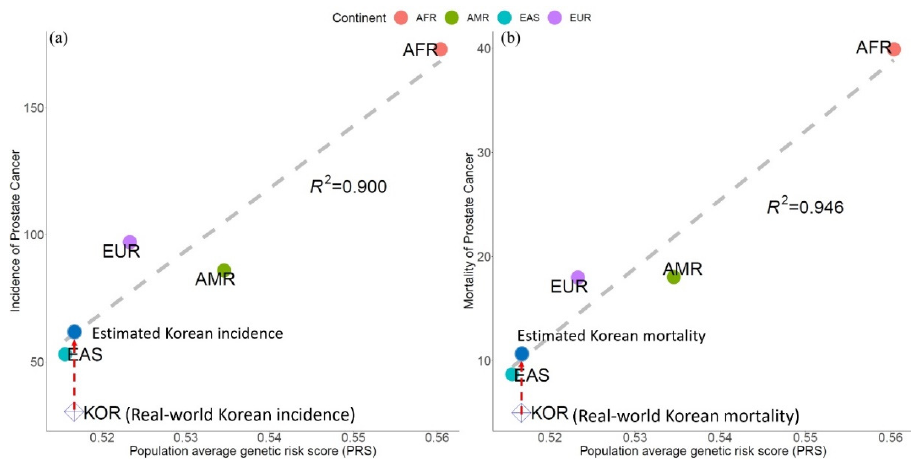
Figure 3. Correlation between population average polygenetic risk score (PRS) and PCa incidence and mortality. ( a ) PRS versus PCa incidence, with linear regression in the grey dashed line ( R 2 = 0.900). The real-world Korean incidence is represented by a blue open rhombus, which deviate from the linear regression line, whereas the estimated Korean incidence is represented by a blue solid circle. ( b ) PRS versus PCa mortality, with the linear regression line shown as a gray dashed line ( R 2 = 0.946). The estimated Korean mortality is represented by a blue open rhombus, which deviates from the linear regression line, whereas the estimated Korean mortality is represented by the blue solid circle. (AMR: American, EUR: European, AFR: African, EAS: East Asian, KOR: Korean). Linear regression of PCa incidence and mortality versus DHT:T ratio showed a pos- itive correlation (Figure 4a and Supplemental Figure S3a). However, R 2 was less than that of the PRS. In addition, PCa incidence and mortality were negatively correlated with Vit D levels (Figure 4b and Supplemental Figure S3b). The data from the Korean DHT:T ratio were calculated and plotted with the Korean PCa epidemiology data to assess the model in Figure 4a, where the real-world data are in the blue targeted circle [20,22] and the real- world data for Vit D.